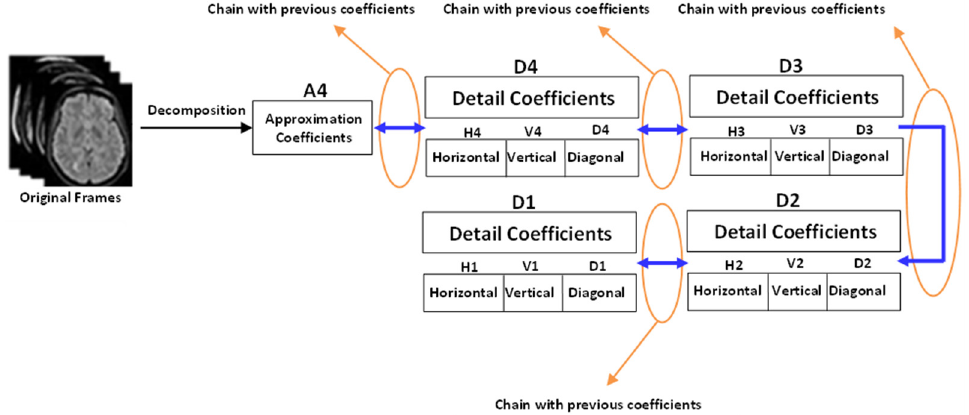
Figure 3. The entire coefficients are connected in the form of a chain.